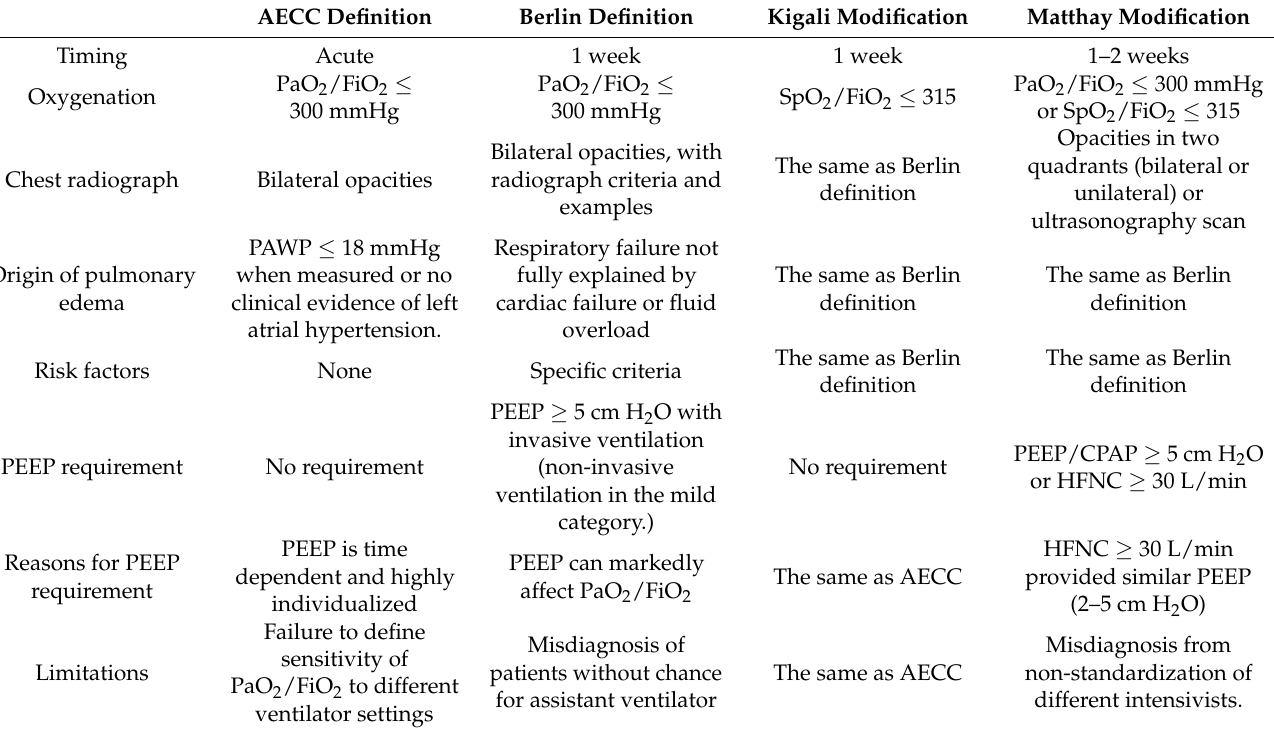
Table 1. The different requirements of PEEP in definition and modifications of ARDS